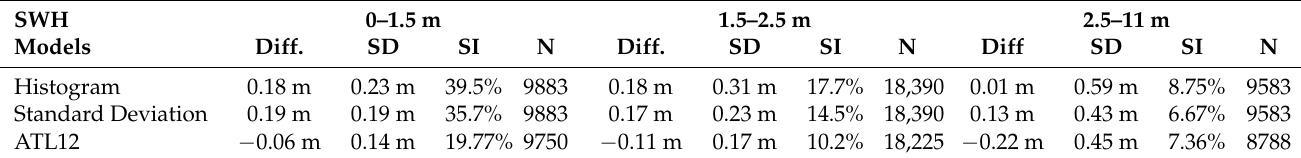
Table 3. Mean difference (Diff.), standard deviation (SD), and scatter index (SI) from the comparison between the models and CryoSat-2, as well as the number of data points (N) for each SWH